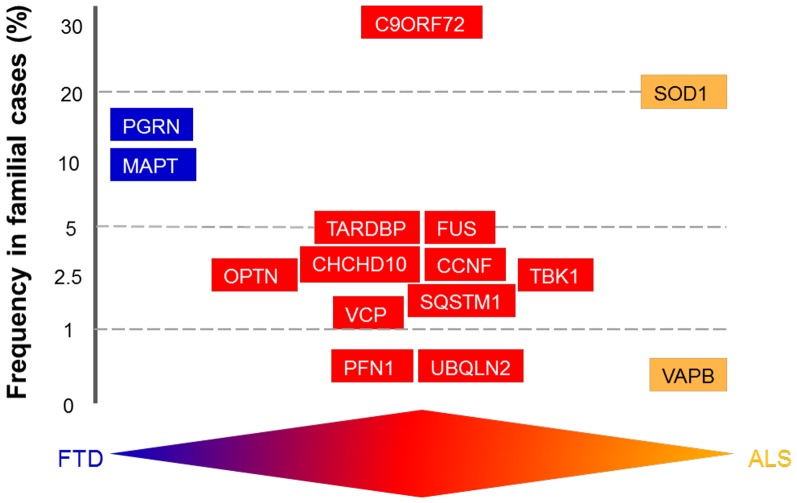
Schematic diagram illustrating genetic overlap of amyotrophic lateral sclerosis (ALS) and frontotemporal dementia (FTD). The genes are distributed according to their mutation frequency in familial forms of ALS and FTD. The available evidence supports the existence of a disease continuum, with mutations in the same genes discovered in patients with FTD (blue), ALS (orange), or ALS/FTD (red).